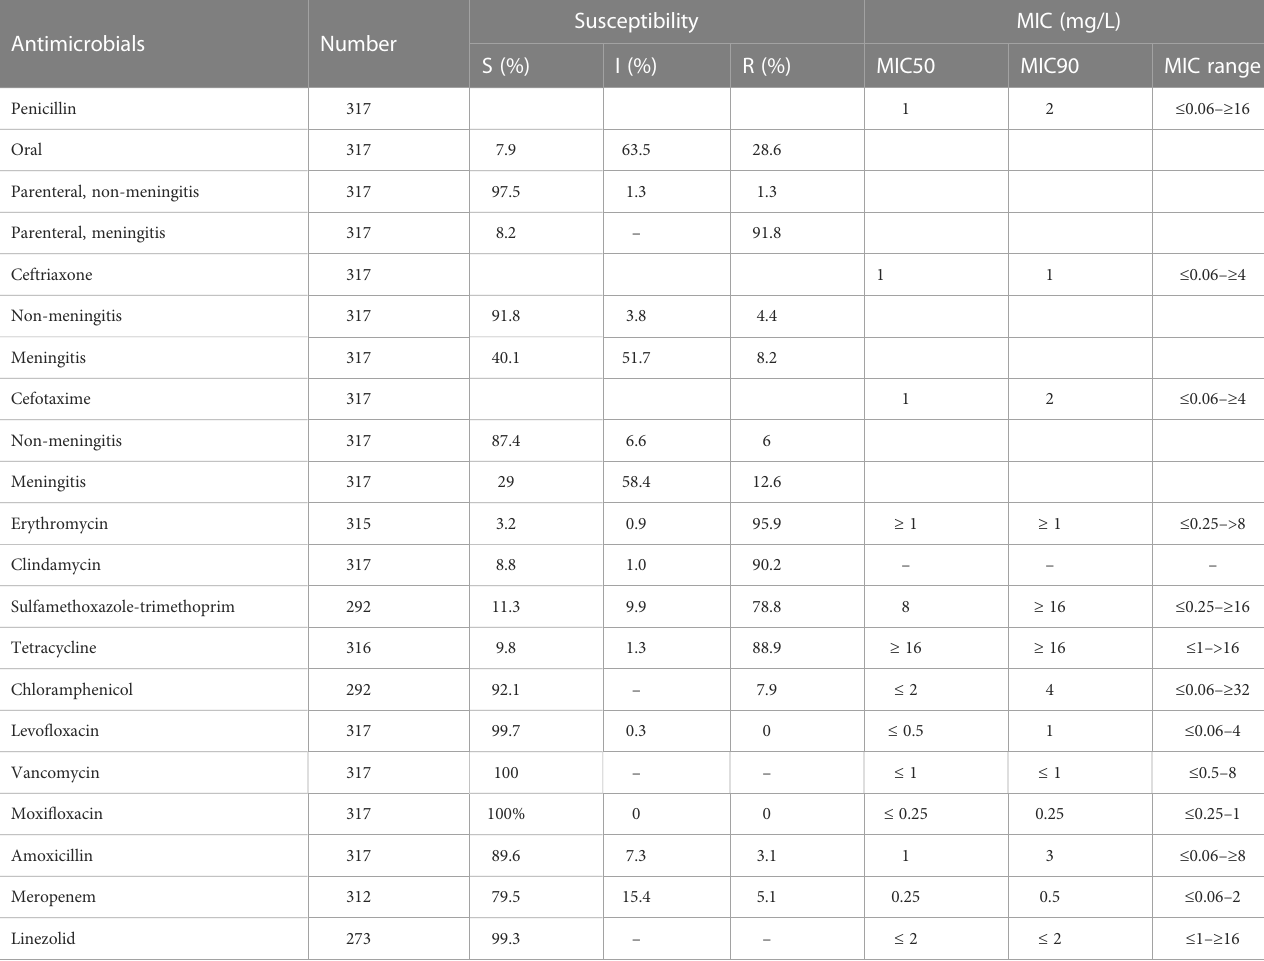
TABLE 2 Antimicrobial susceptibility test results of 317 isolates of S. pneumoniae isolated in Urumqi, 2014 – 2021.